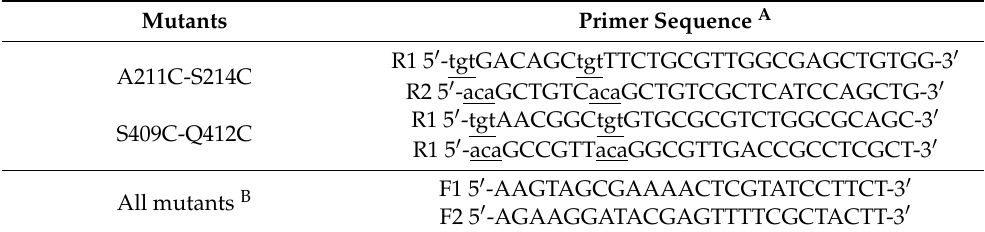
Table 1. Primers used for desired mutagenesis. Mutants Primer Sequence